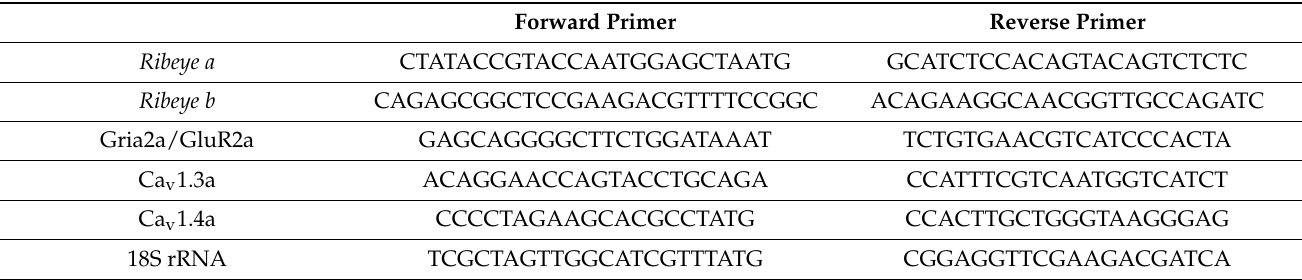
Table 2. Primers used for RT-qPCR